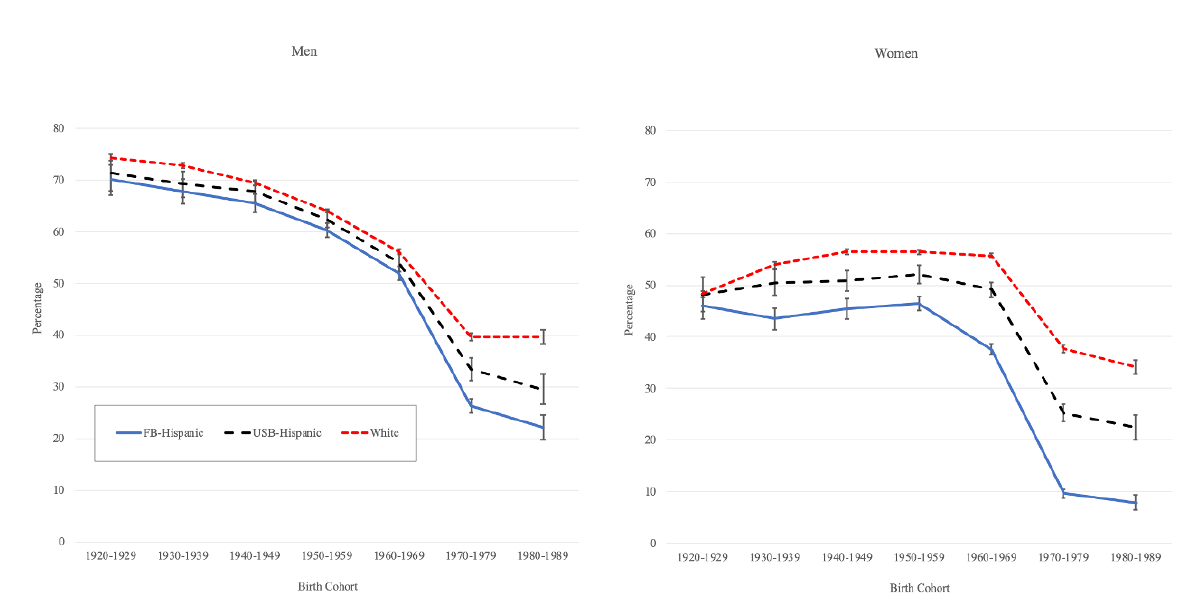
Figure 1: Percentage smoked for five or more years by age 25 by birth cohort, ethnicity/nativity, and gender. Source: 1989 to 2014 National Health Interview Survey and 1999 to 2014 National Health and Nutrition Examination Survey. FB, foreign-born; USB,